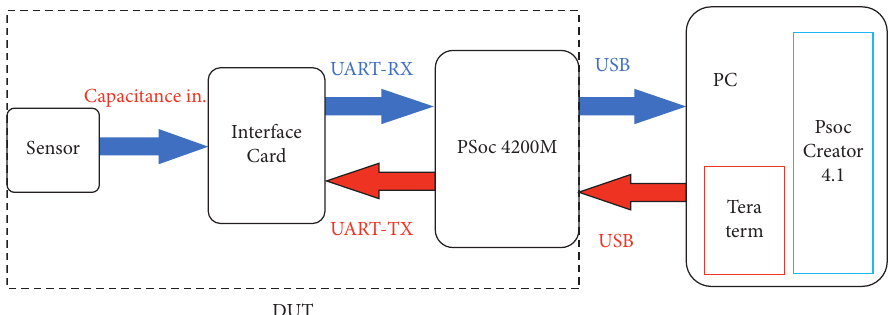
Figure 14: Measurement diagram for the fluid level system.